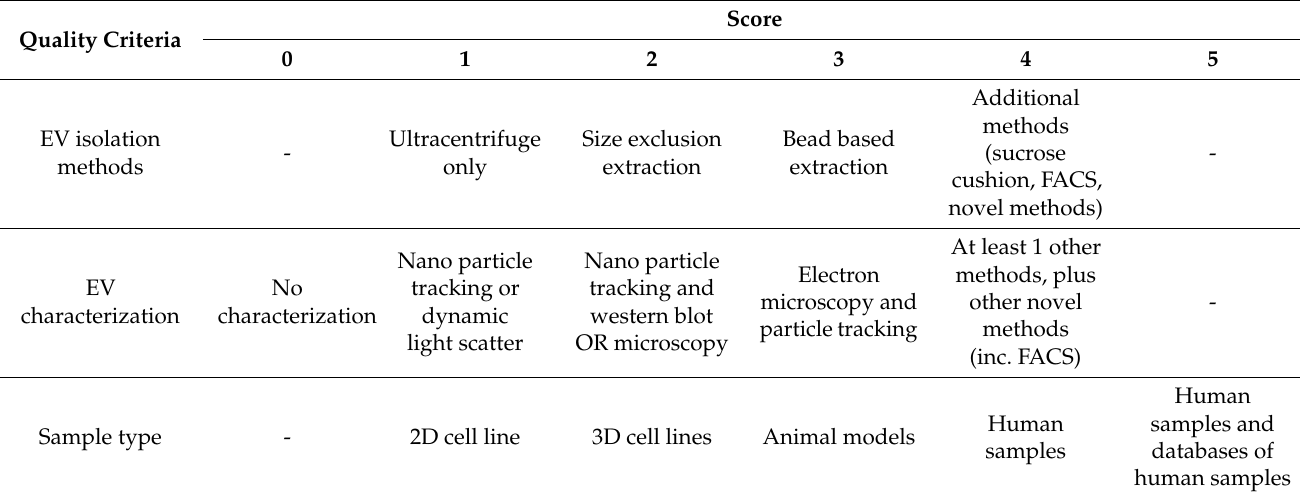
Table 1. Quality assessment score summary.